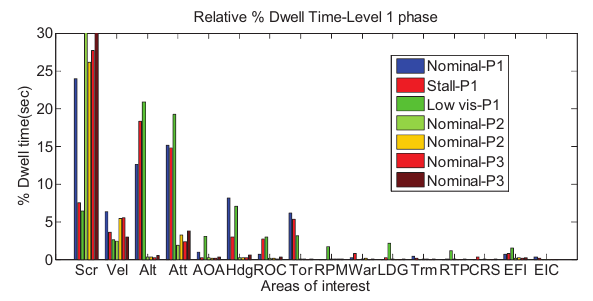
Figure 9. PDT in first level segment